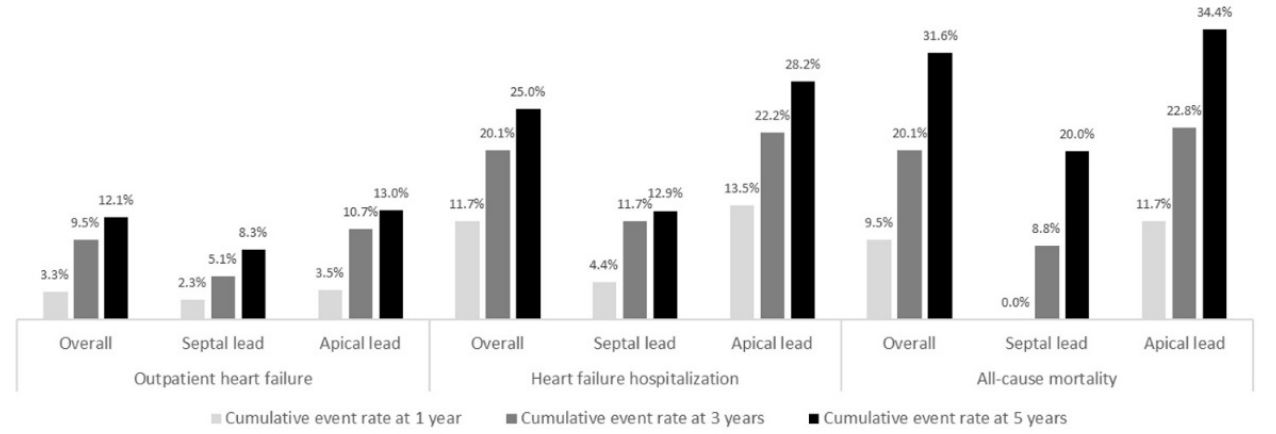
Figure 1. Cumulative heart failure and all-cause mortality event rate at 1, 3, and 5 years of follow-up. Median percentage of ventricular pacing was 84% (IQR 16–99), 67% of them with ≥ 40%, without significant differences between groups. QRS duration during RV pacing was available in 105 (43.0%) patients and it was lower in RVS pacing group. LVEF during follow-up was available in 135 (55.3%) subjects and it was lower than 50% in 35.6% of patients, and similar between groups. Upgrade to cardiac resynchronization therapy was performed in 2.5% of patients (three subjects in each group); however, in each group, only one of these had LVEF ≥ 50% at